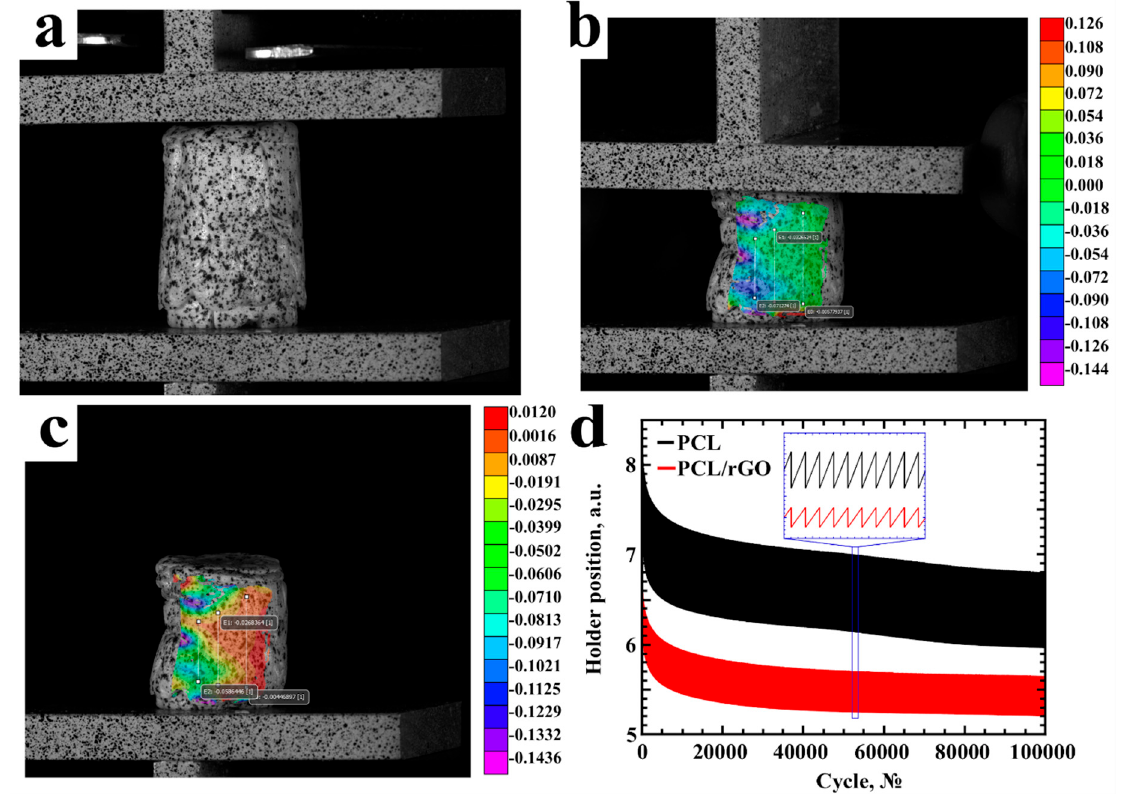
Figure 6. Mechanical studies of PCL samples with loads from 20 to 50 N. ( a ) Sample without loading; ( b ) stress field, obtained with use of DIC (Digital Image Correlation) during the mechanical tests; ( c ) DIC system loading after the mechanical measurements; ( d ) fatigue tests (inset shows the close up of the cycling compression test curve).